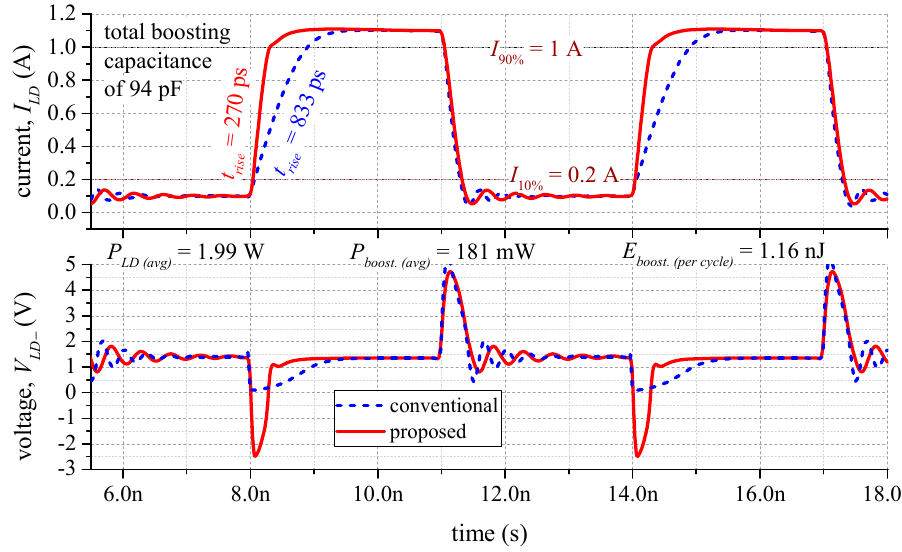
Figure 8. The simulation results of driving current and voltage for the proposed vs. conventional driver.